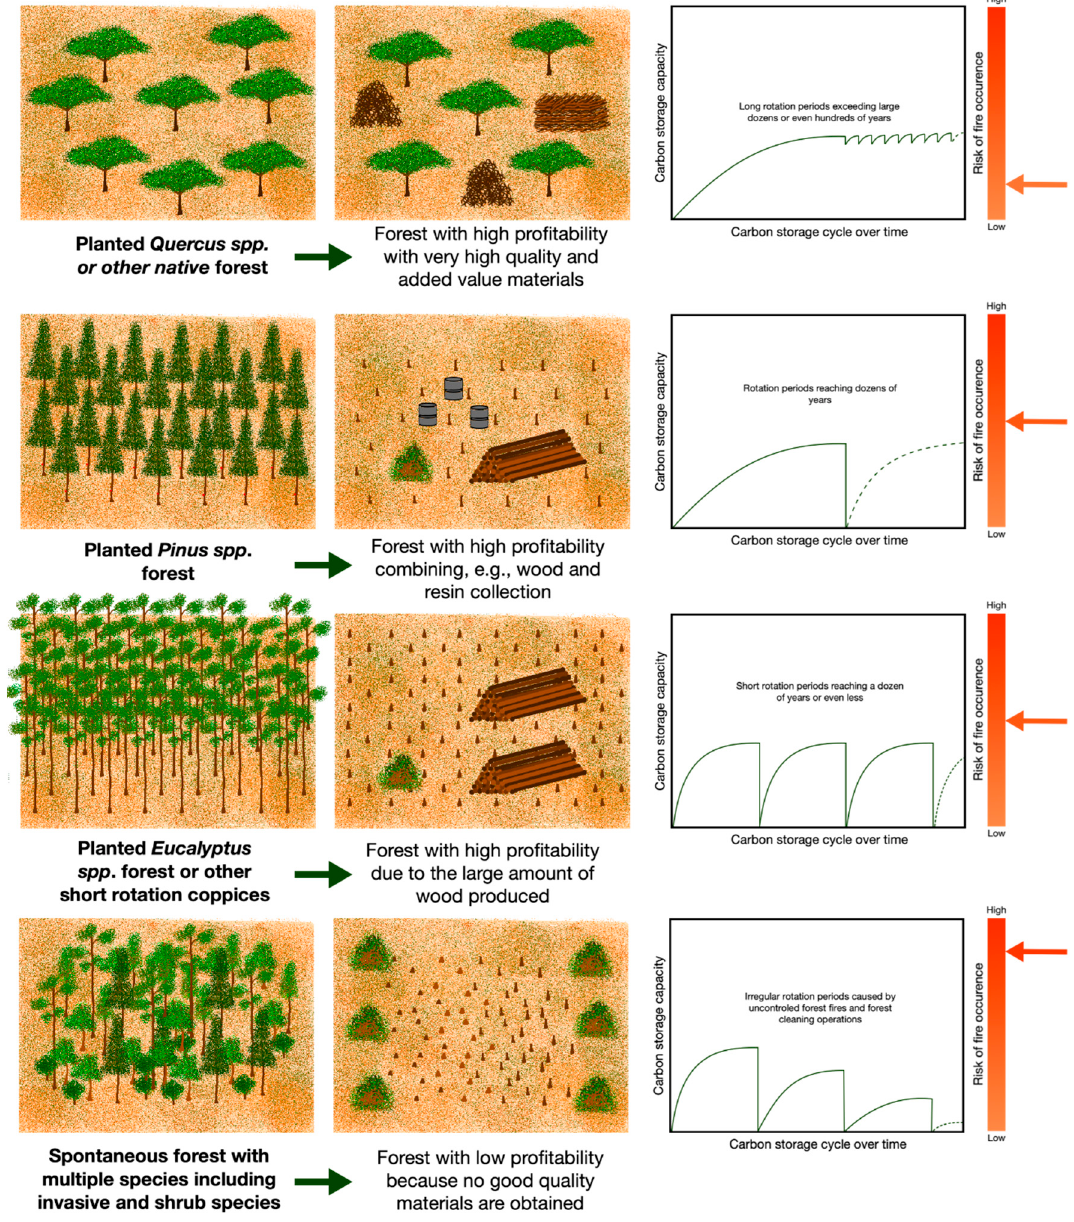
Figure 10. Relationships between different types of forest with potential economic performance, carbon storage capacity, and fire risk. Fire risk is a variable that has to be introduced, as this risk depends on the ability of temperate forests to keep carbon stored for longer periods, but also on the potential interest of forest owners to make a particular type of forest to the detriment of another.